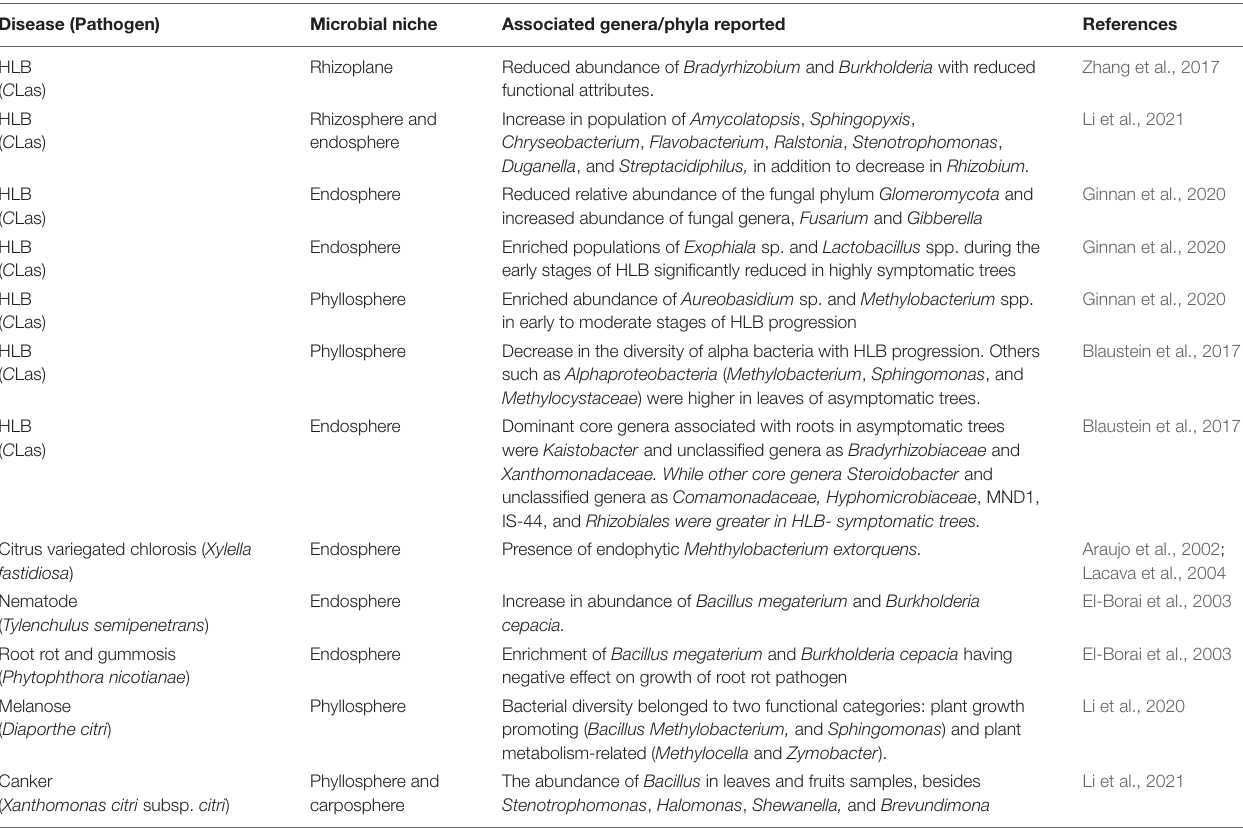
TABLE 2 | Effect of important diseases on various changes in the citrus microbiome. Disease